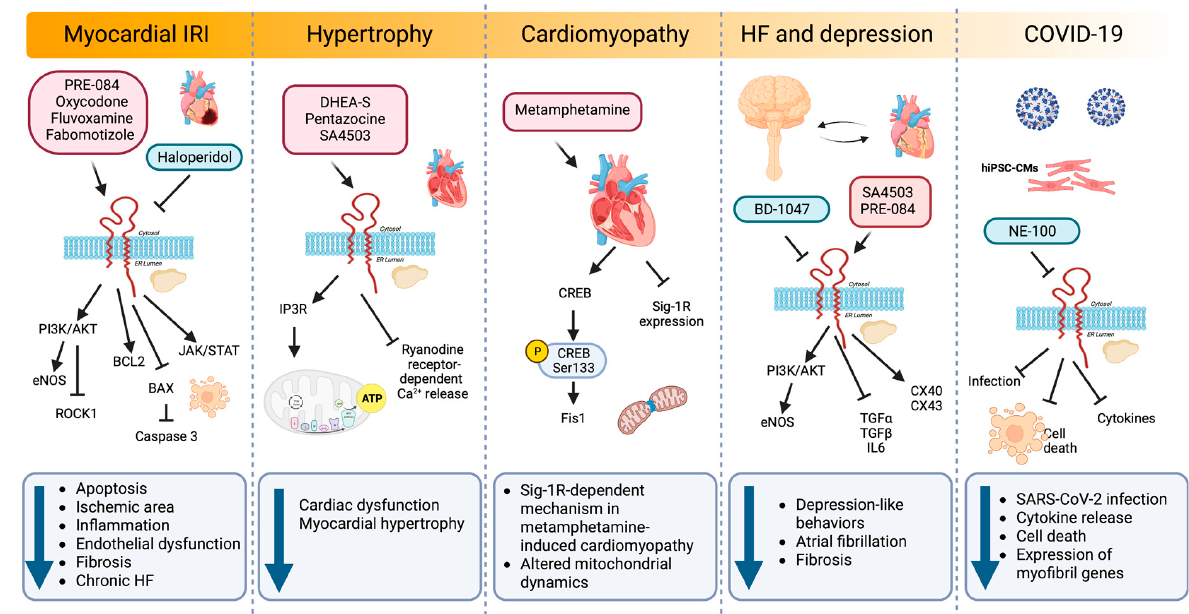
Figure 6. Sig-1R signaling pathways regulating cardiac injury. Sig-1R agonists and antagonists in experimental and preclinical models of myocardial IRI, hypertrophy, cardiomyopathy, depression, and COVID-19 activate diverse signaling pathways that impact cellular processes such as apoptosis, inflammation, endothelial dysfunction, fibrosis, hypertrophy, mitochondrial dynamics, atrial fibrillation, and gene expression.